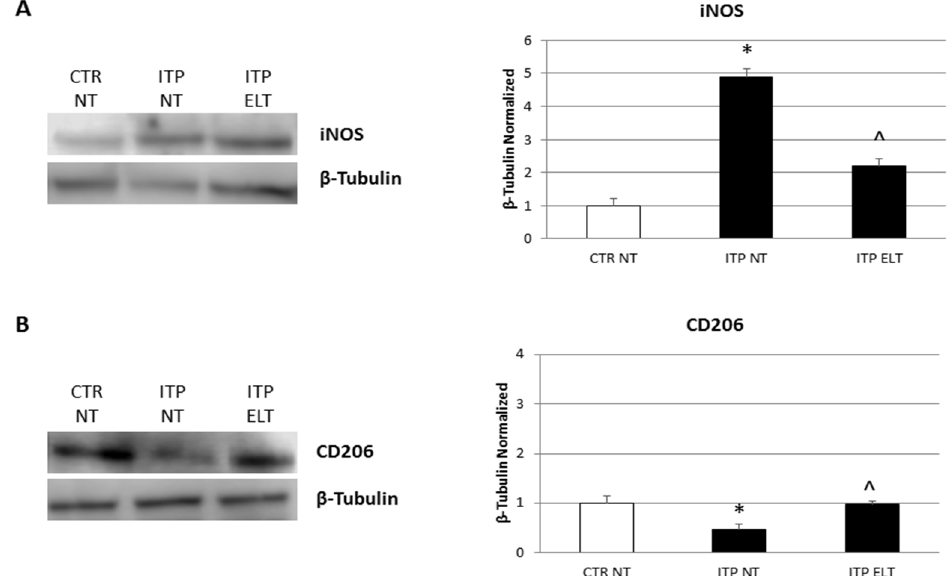
Figure 1. Effect of Eltrombopag (ELT) on Nitric Oxide Synthase (iNOS) and Cluster of Differentiation 206 (CD206) protein expression. ( A ) iNOS protein expression levels in Immune Thrombocytopenia (ITP) macrophages compared with CTR (control) macrophages, determined by Western Blot, starting from 20 µ g of total lysates after treatment with Eltrombopag (6 µ M). ( B ) CD206 protein expression levels in ITP macrophages compared with CTR macrophages, determined by Western Blot, starting from 20 µ g of total lysates after treatment with ELT (6 µ M). The most representative images are displayed. The proteins were detected using Image Studio Digits software (LI_COR Biotechnology ®, Lincoln, Nebraska USA)and the intensity of immunoblots compared to the untreated control, taken as 1 (arbitrary unit), were quantified after normalizing with respective loading controls for the housekeeping protein β -Tubulin. Histogram shows iNOS ( A ) and CD206 ( B ) expression levels as the mean ± S.D. of independent experiments on each individual sample. A t -test was used for statistical analysis. * indicates p ≤ 0.05 compared to Non-treated Control (CTR NT), ˆ indicates p ≤ 0.05 compared to ITP NT.